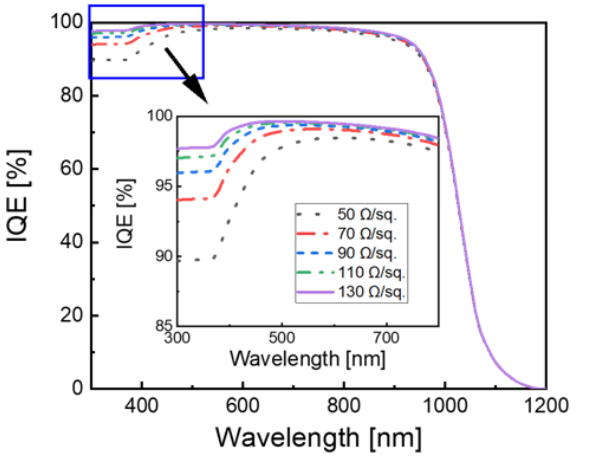
Figure 6. Simulated internal quantum efficiency as a function of R sheet